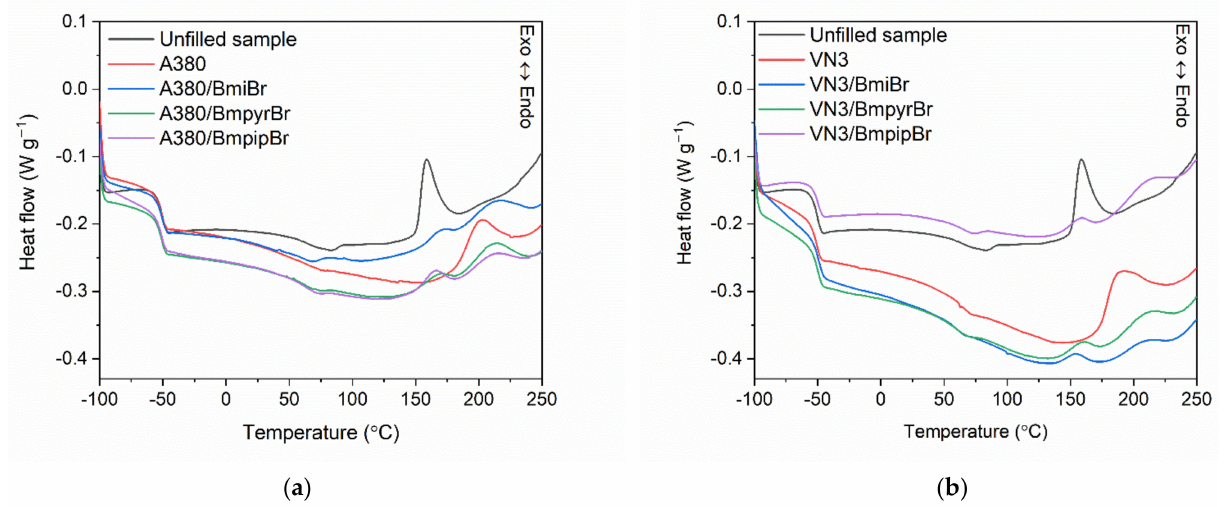
Figure 5. Differential scanning calorimetry (DSC) curves of SBR compounds filled with: ( a ) A380; ( b ) VN3. Table 5. Differential scanning calorimetry (DSC) of SBR compounds filled with A380 and VN3 silica (T g , glass transition temperature; ∆ C p , heat capacity; T onset , the onset temperature of crosslinking; T endset , the endset temperature of crosslinking; ∆ H, enthalpy of crosslinking). ∆ C T g T p Compounds ( ◦ C) (J/g × K)